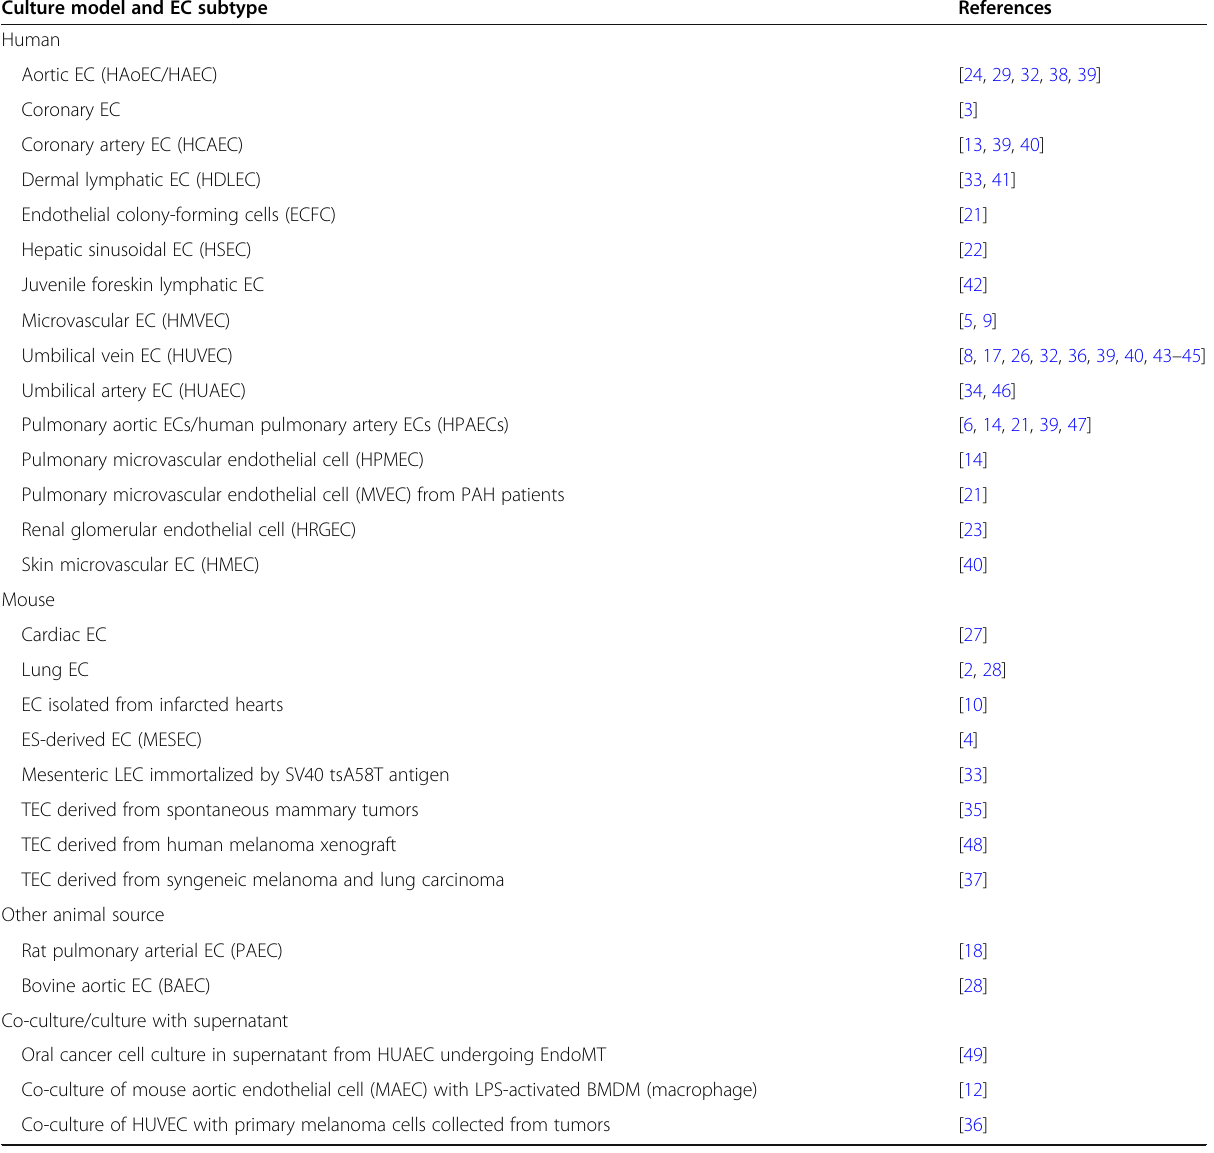
Table 3 In vitro models in the studies introduced in this review. EC subtypes or other cell types co-cultured with EC/cultured in supernatant from